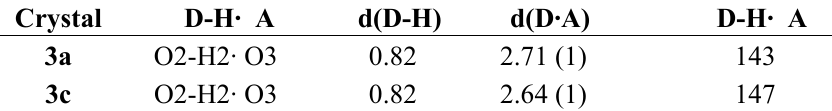
Table 4. Hydrogen bonding distances [Å] and angles [°] for 3a and 3c